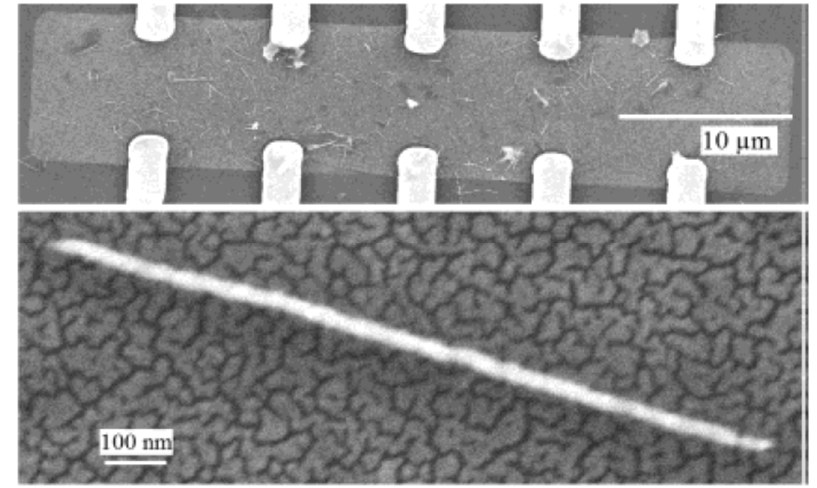
Figure 2. SEM image of a nanocell after assembly of the Au nanowires and mononitro oligo(phenylene ethynylene) compound. Top : five pairs of leads across the nanocell; Bottom : higher magnification of the central portion of the nanocell with an attached Au nanowire, which is affixed via the derivative of mononitro oligo(phenylene ethynylene). Reproduced with permission from [22], © American Chemical Society, 2003.